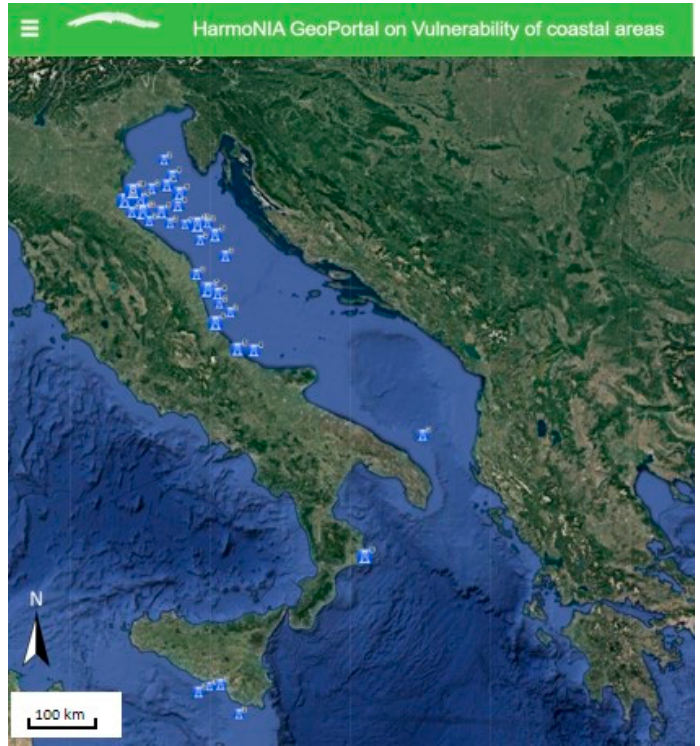
Figure 1. Location of 148 operating oil and gas platforms for exploitation of hydrocarbons in the Adriatic-Ionian (ADRION) area (HarmoNIA GeoPortal, Source: EMODnet Human Activities).